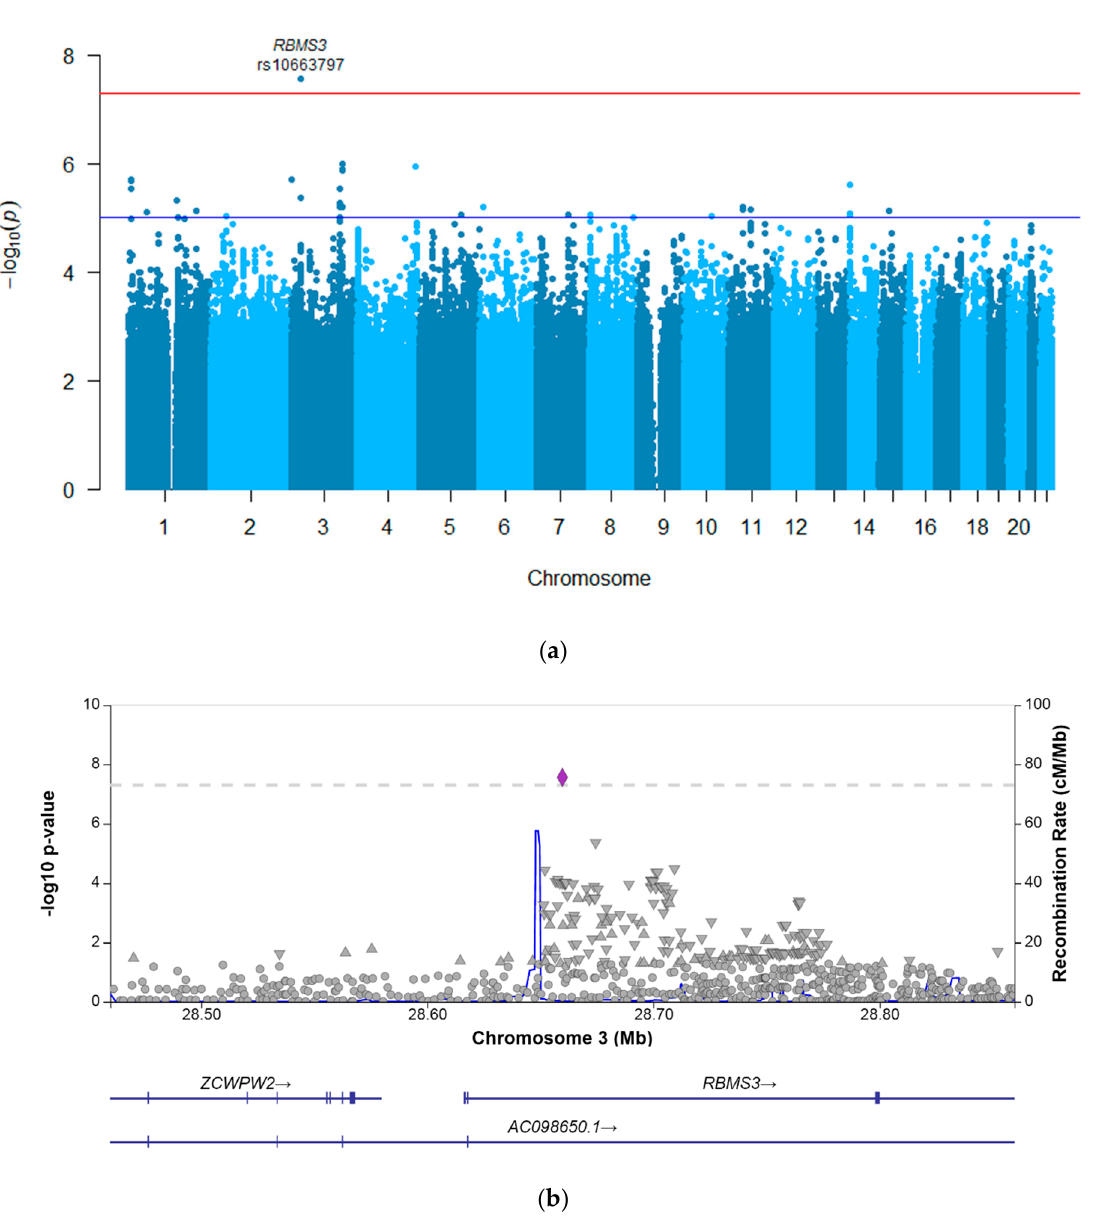
Figure 1. Results of GWAS investigating eGFR decrease after platinum. p -values were generated using logistic regression. ( a ) Manhattan plot showing the associations between eGFR decrease and genetic variants (blue dots), plotted against chromosomal position (x-axis) and − log10 p -value (y-axis). The red line represents the p -value threshold for genome-wide statistical significance ( p < 5 × 10 − 8 ). The blue line represents a suggestive p -value threshold ( p < 10 − 5 ). ( b ) LocusZoom plot showing the variant rs10663797 and its surrounding region, which was the variant most strongly associated with eGFR decrease. This variant (purple diamond) is located in the intronic region of the RBMS3 . The p-values on the − log10 scale are plotted on the left y-axis. The right y-axis indicates the regional recombination rate (cM/Mb), depicted by the blue line on the plot (where peaks indicate recombination hot spots). The chromosomal position is plotted along the x-axis, along with the genes located in that